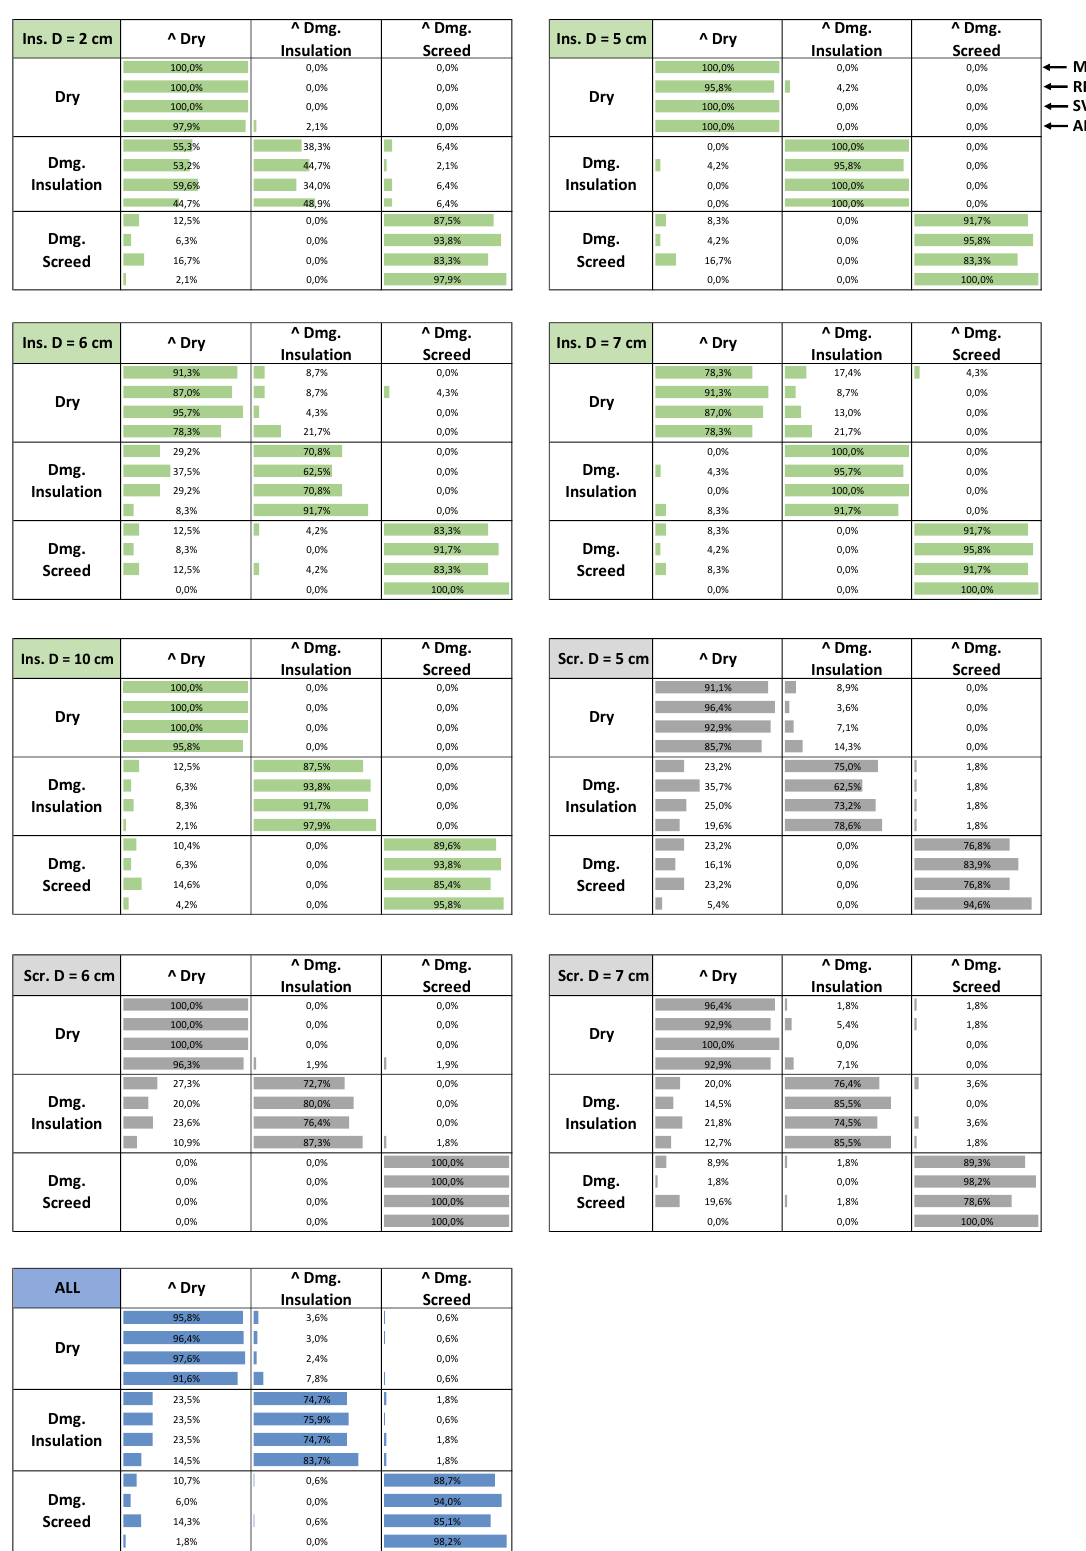
Figure 12. Combined confusion matrices for the individual insulation (green) and screed (gray) thicknesses considered in the experiment. The classifier’s accuracies within one cell are presented in the same order as in Table 2. Rows and columns include the actual and the predicted (^) scenario, respectively. The blue confusion matrix summarizes the overall accuracies for each